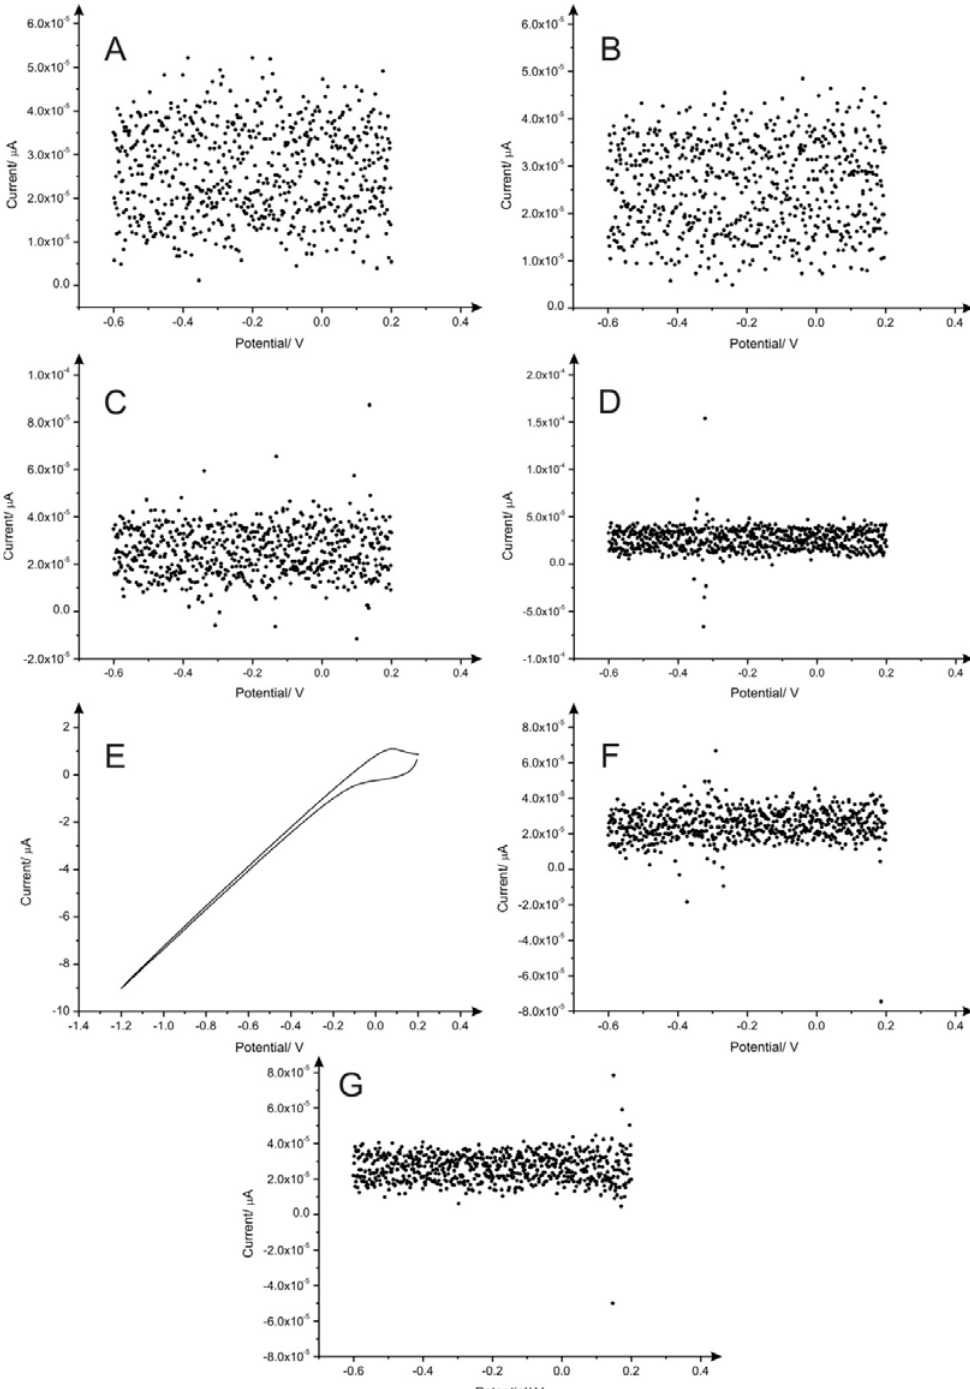
Figure S1. Cyclic voltammograms of 60 times drawn PDEs fabricated applying different pencil grades B ( A ), 2B ( B ), 3B ( C ), 4B ( D ), 7B ( E ), 8B ( F ) and 9B ( G ) from Box 1. Redox probe: hexaammineruthenium(III) chloride / 0.1 M KCl. Scan rate: 5 mV·s − 1 .